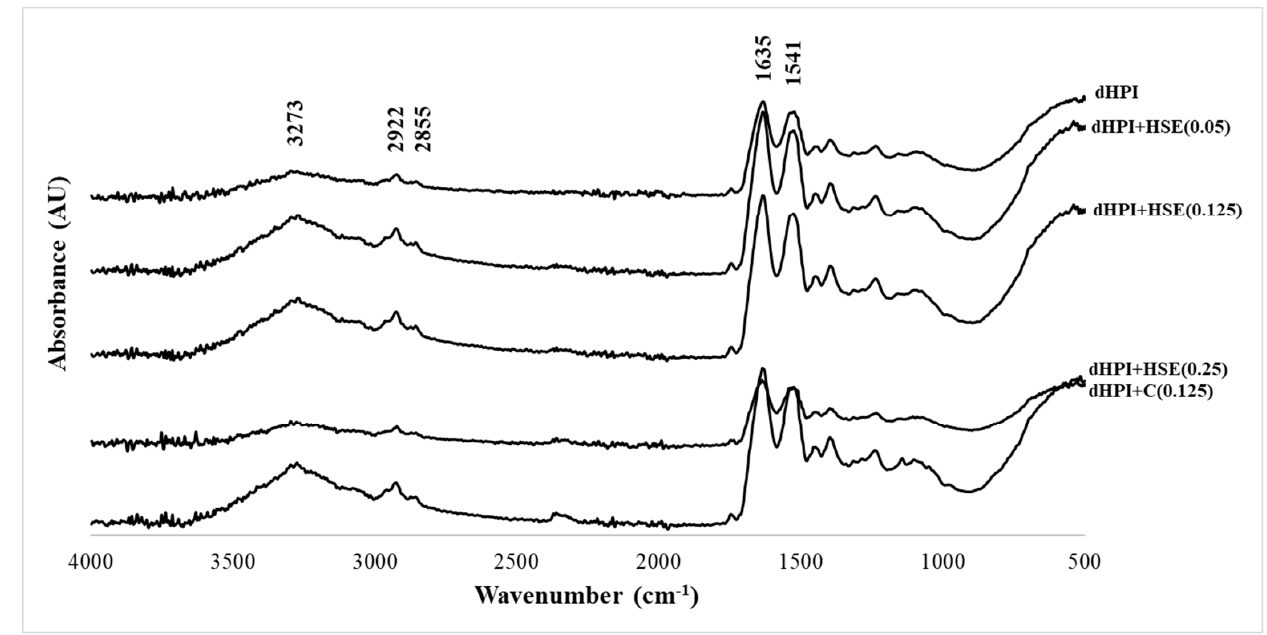
Figure 6. FTIR spectra of dHPI, dHPI+HSE complex, and dHPI+C complex. No new bands were formed in dHPI+HSE or dHPI+C complex formation. Thus, the protein–phenolic complex formation was mostly a physical process, and no covalent bonds were created between the matrix and the core [60]. Further, dHPI+HSE or dHPI+C complexes caused differences in all amide bands of native hazelnut protein. The amide A band of dHPI+HSE complexes was slightly shifted to 3276 cm − 1 , while dHPI+C complex had no shifts. The amide B band is attributable to the C–H tensile vibration of the CH 3 and CH 2 groups of protein [42]. The amide B band of all dHPI–phenolic complexes was shifted to 2925 cm − 1 .